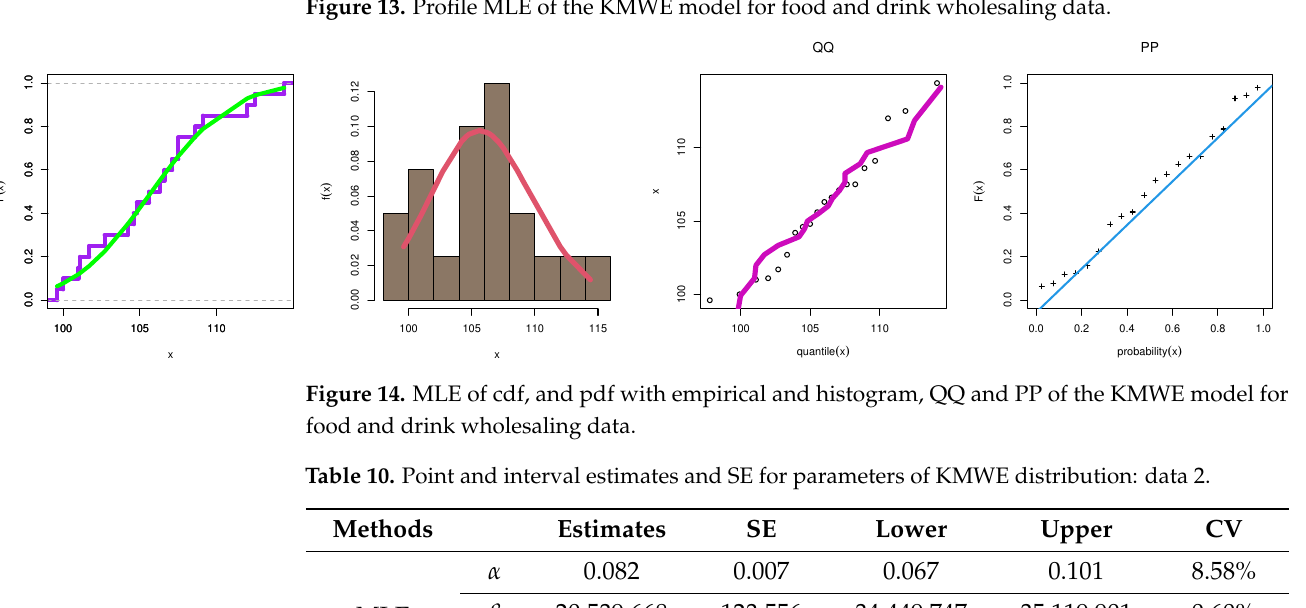
Figure 13. Profile MLE of the KMWE model for food and drink wholesaling data.